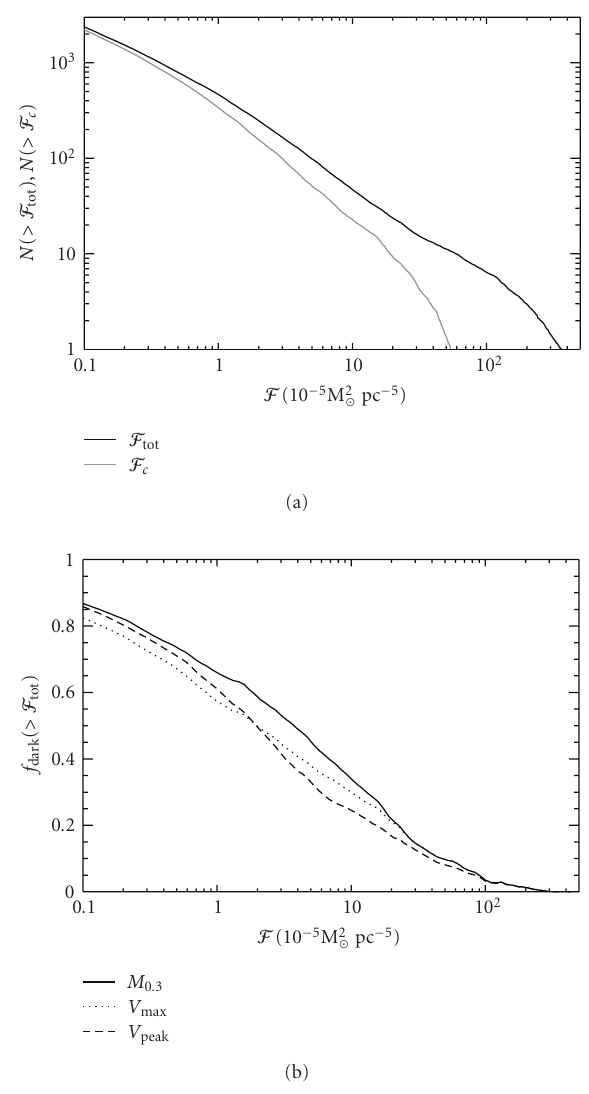
Figure 5: (a) The cumulative number of subhalos with flux exceeding F tot , F c . (b) The fraction of dark clumps, that is, subhalos likely not hosting any stars and defined by M 0 . 3 < 5 × 10 6 M (cid:2) , V max < 8kms − 1 , or V peak < 14km s − 1 , as a function of limiting flux F tot . These distributions are averages over 100 randomly chosen observer locations 8kpc from the host halo